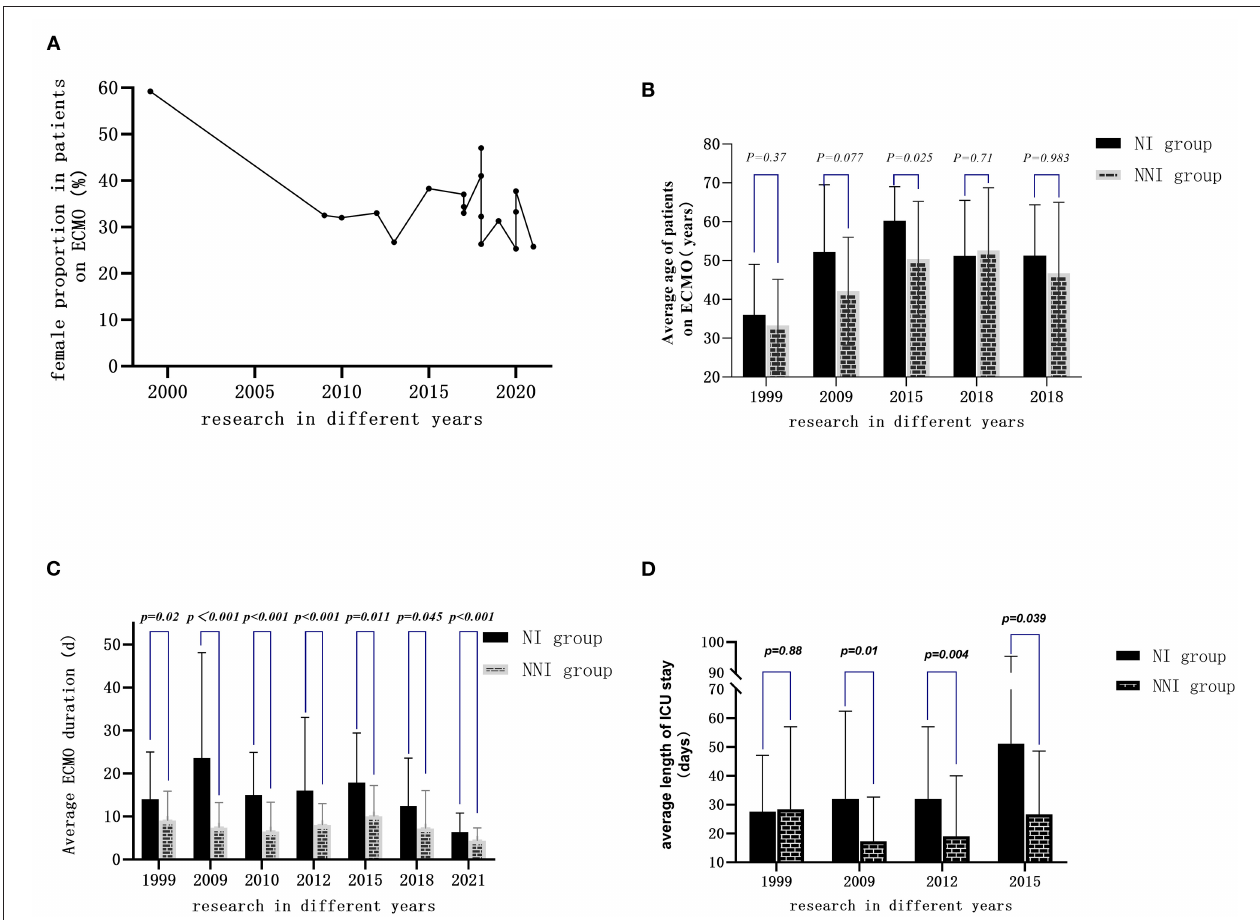
FIGURE 3 | General clinical characteristics of adult patients treated by ECMO in different years: (A) Proportion of female patients in most of the studies ranged from 25 to 40%. (B) Average age of the patients ranged from 33 to 60 years old. (C) Duration of ECMO use extracted from seven studies (expressed as mean ± SD) ranged from 5 days to more than 23 days. (D) Length of ICU stay in the infected group was longer than in the non-infected